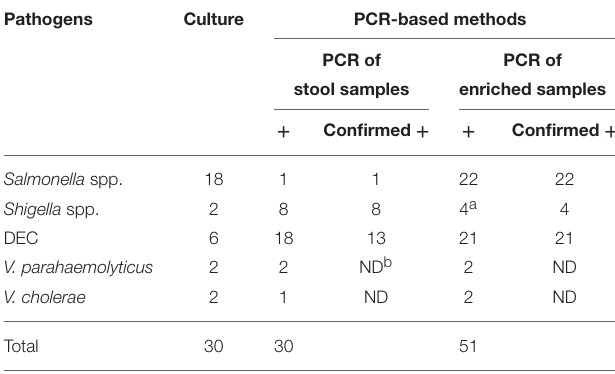
TABLE 3 | Summary of the detection results in this